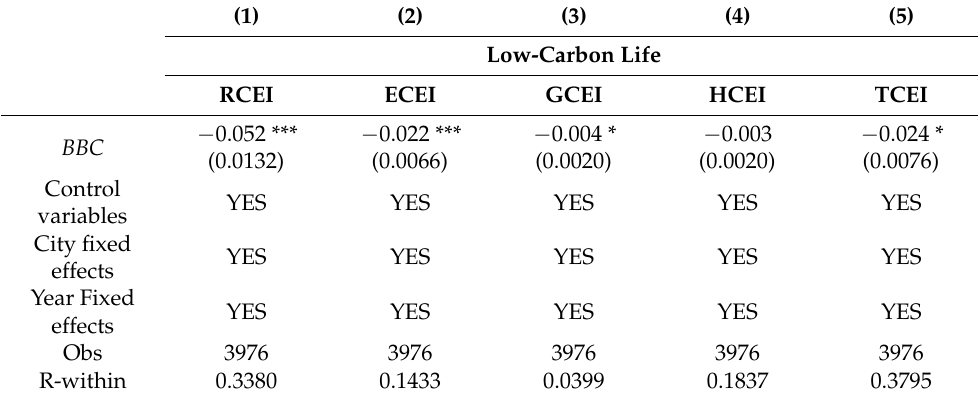
Table 7. Information infrastructure and low-carbon